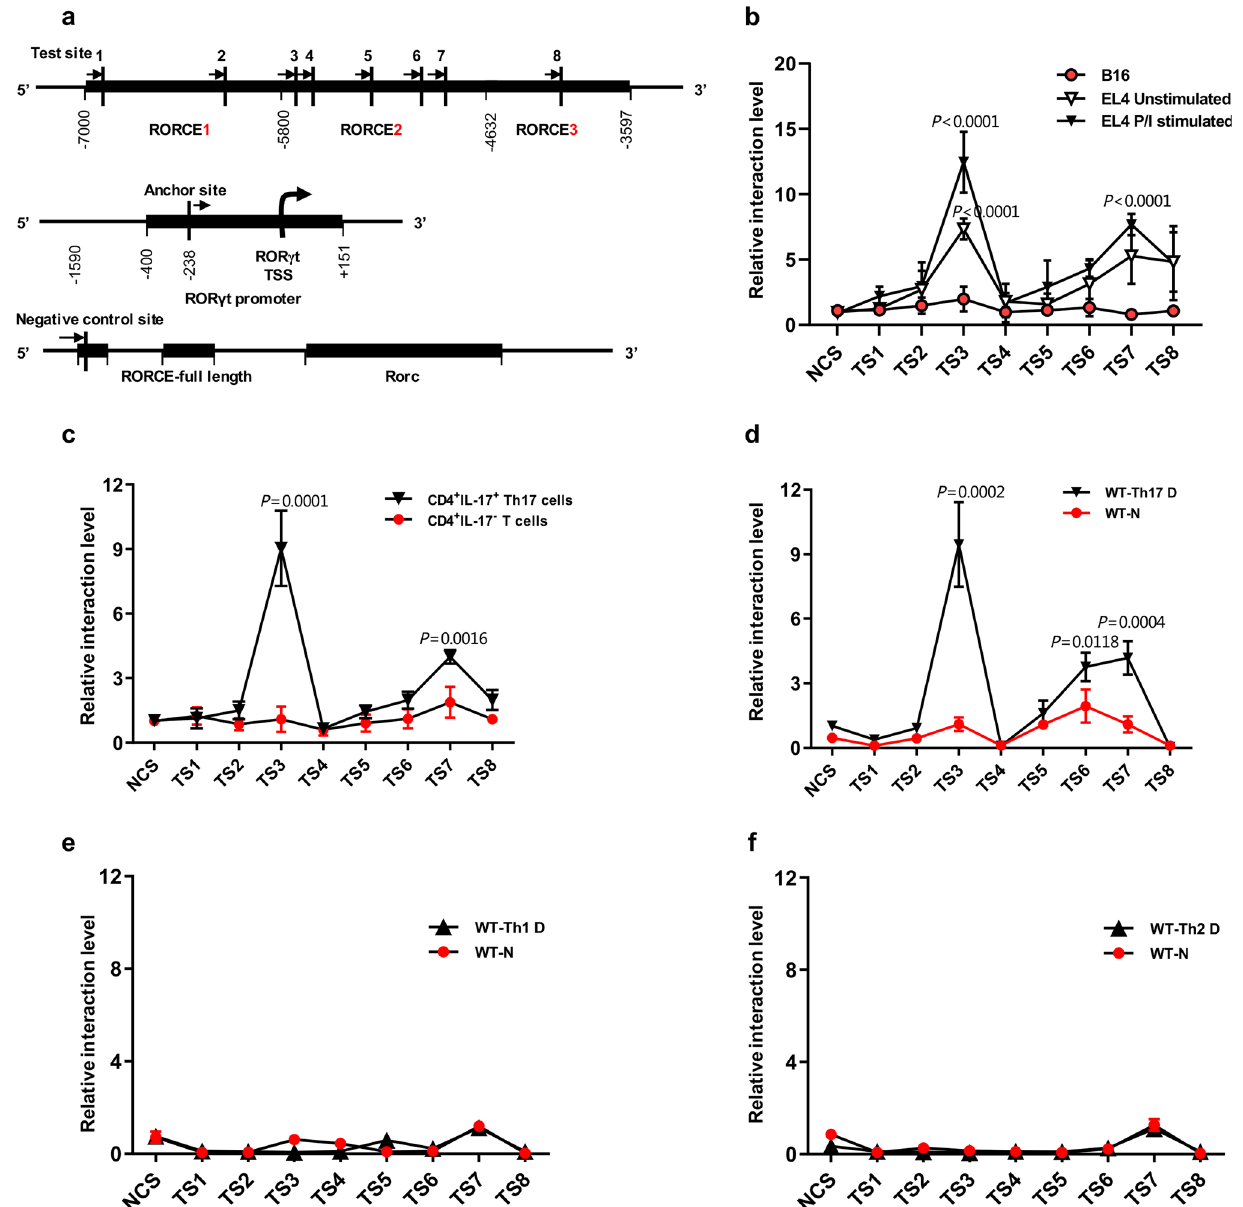
Fig. 5 3C analysis of the RORCE region. a Map of the investigated interactions. Since we found NlaIII to be the only restriction enzyme that allowed suf fi ciently high-resolution analysis of RORCE, NlaIII was fi nally used to digest the RORCE region. The positions of NlaIII sites (vertical lines) in RORCE used in this 3C analysis are indicated as test sites 1 to 8 (TS1 to TS8). The NlaIII site in ROR γ t gene promoter was taken as the anchor site (AS), from which possible interactions with other regions of RORCE were quanti fi ed. The primers used for 3C-qPCR are indicated by simple black arrows. The negative control site (NCS) is another NlaIII site upstream of RORCE, which does not interact with the AS. b – f Quantitative analysis of a 3C-qPCR assay assessing the RORCE region. The data represent relative interaction frequencies between AS and the other tested sites (TS1 to TS8) in the RORCE region. Relative interaction frequencies were determined by qPCR relative to standard curves as described in the “ Methods ” section. Data points represent the mean ± SEM for PI-stimulated EL4 ( b , n = 4 independent experiments), FACS-puri fi ed CD4 + IL17 + Th17 ( c , n = 5 independent experiments), Th17-polarized ( d , n = 5 independent experiments), Th1-polarized ( e , n = 5 independent experiments), and Th2-polarized cells ( f , n = 5 independent experiments) from WT mice. Th17 D, Th1 D, and Th2 D represent Th17, Th1, or Th2 differentiation under the appropriate polarization conditions, respectively, and N represents naïve cells. All P -values are based on unpaired two-tailed Student ’ s t -test ( b – d ). Experimental mice were between 8 and 12 weeks of age, with no preference to gender and were maintained on a C57BL/6 background. Source data are provided as a Source Data fi ChIP-qPCR . Cells were cross-linked using 1% formaldehyde for 10min at 37°C and After 24h of transfection, the cells were treated with PMA (50ng/ml, Sigma-Aldrich) then sonicated (Bioruptor; Diagenode). The DNA – protein complexes were isolated and ionomycin (1µM, Calbiochem) for 4h. The cells were harvested, lysed, and using a ChIP assay kit (Beyotime) according to the manufacturer ’ s instructions with assessed with a dual-luciferase reporter system (Promega). The Renilla luciferase indicated antibodies 44 . The following antibodies were used for ChIP: anti-H3K4me1 activity of pRL-TK (Promega) was used to normalize the transfection ef fi ciency and fi re fl y luciferase activity of the reporter constructs. All values were obtained from (1:250, Abcam, ERP16597), anti-H3K27Ac (1:250, Abcam), anti-SOX-5 (1:250, experiments performed in triplicate and repeated at least three times. Statistical sig- Abcam, ab94396), and anti-STAT3 (1:250, Cell Signaling Technology, 124H6). Pur- ni fi cance between groups was determined using Student ’ s t -test (GraphPad Prism 8). i fi ed DNA was subjected to qPCR analysis using SYBR Green master mix (TakaRa).